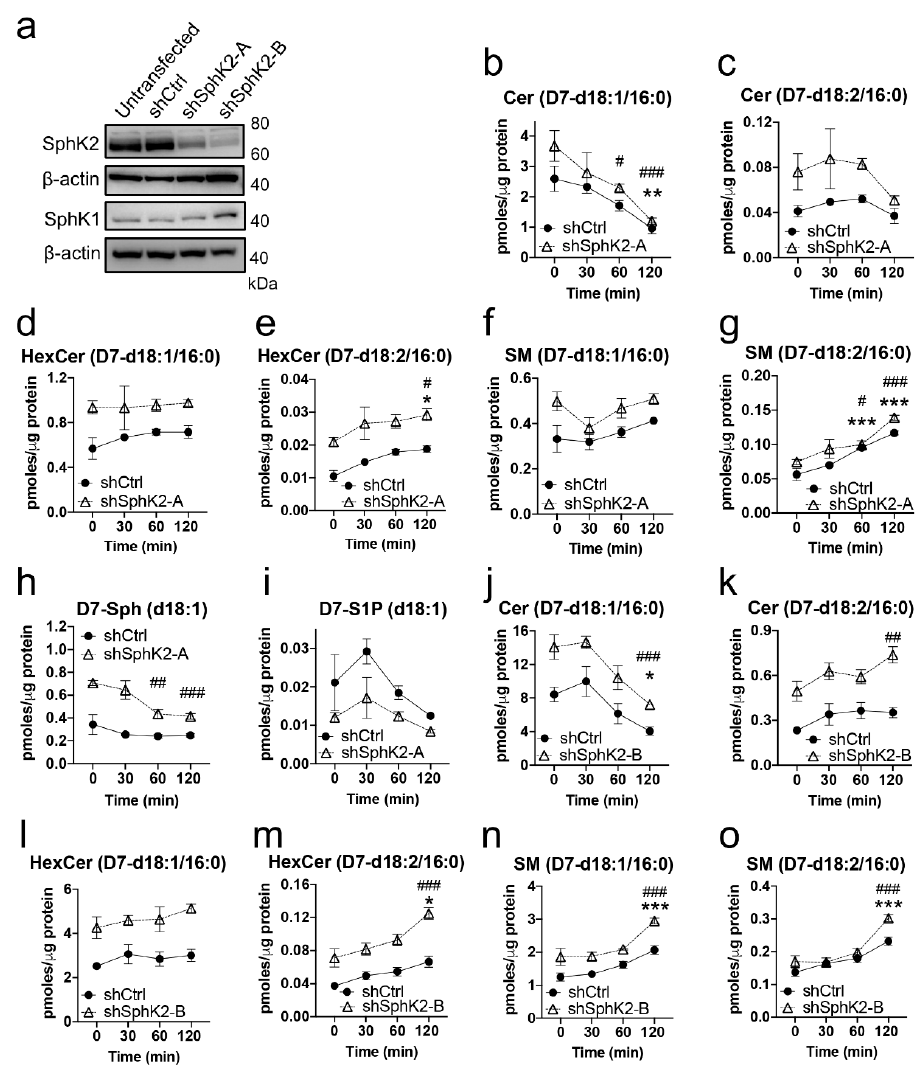
Figure 6. d18:1 ceramides are metabolized more rapidly than d18:2 ceramides. ( a ) Western blots